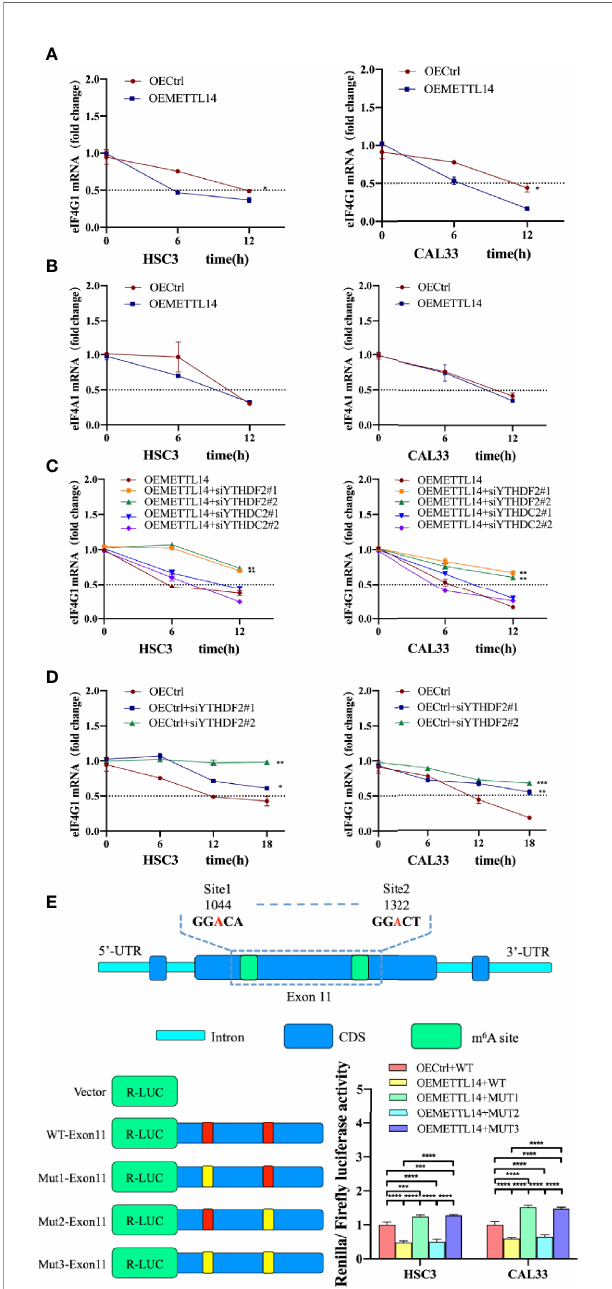
FIGURE 3 | METTL14 regulated the stability of eIF4G1 mRNA via methylation. RNA stability assaysshowed eIF4G1 (A) and eIF4A1 (B) mRNA half-lives (t 1/2 ) in OEMETTL14 cells compared with OECtrl cells. YTHDF2 or YTHDC2 were silenced based on OEMETTL14 (C) orOECtrl (D) , followedby the detection of eIF4G1 mRNA t 1/2 . (E) Dual-luciferase reporter andmutagenesis assayswere used to determine key targets oneIF4G1 for METTL14 to regulatedegradation. ( p or adjusted- p *< 0.05, **<0.01, ***< 0.001,